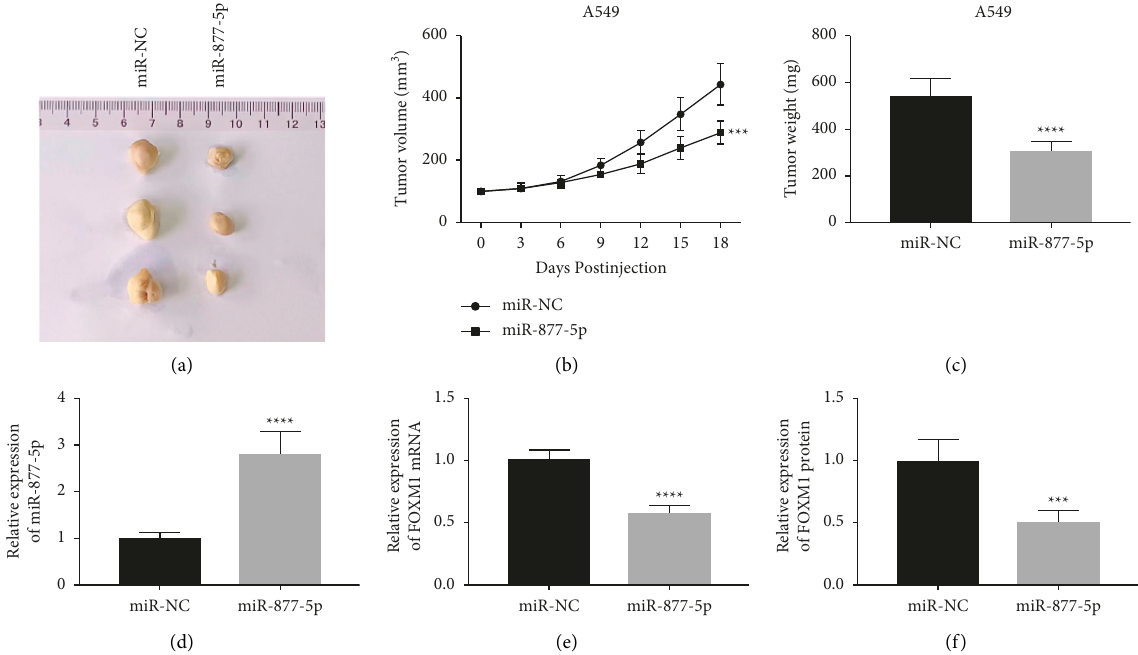
Figure 6: miR-877-5p overexpression’ suppresses tumorigenesis of NSCLC in vivo . (a) Representative images of tumor tissues. (b) The tumor growth curve. (c) The mice were killed and tumor tissue was weighed on day 18. (d) miR-877-5p expression in the tumors. The mRNA (e) and protein (f) expression of FOXM1 in the tumors. ∗ P < 0 . 05, ∗∗ P < 0 . 01, ∗∗∗ P < 0 . 001, and ∗∗∗∗ P < 0 . 0001.